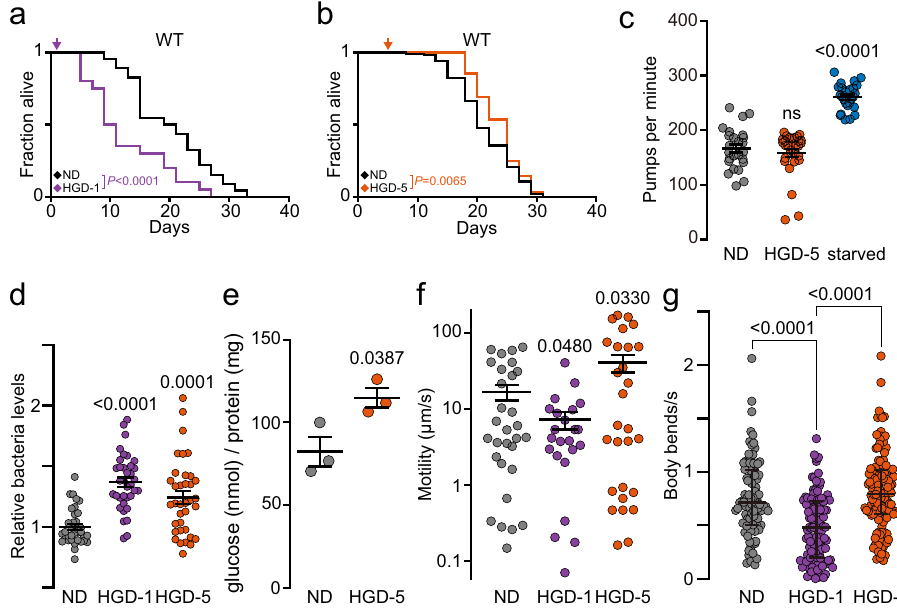
Fig. 1 | Glucose extends lifespan of aged but not of young adult worms. a LifespanassaysofWTnematodesfedwithUV-killed E.coli OP50diet(normaldiet, ND) alone or supplemented with 2% glucose (high glucose diet, HGD) at 1-day old (D1, HGD-1) and b 5-day old (D5, HGD-5) worms (NDa, n =170; HGD-1, n =90; NDb, n =722; HGD-5, n =772 including biological replicates). c Pharyngeal pumping rate (ND, n =25; HGD-5, n =28; starved, n =25), d Bacteria intake relative to bacteria clearancewithinWTNDafter3dayincubation(ND, n =417;HGD-1, n =424;HGD-5,